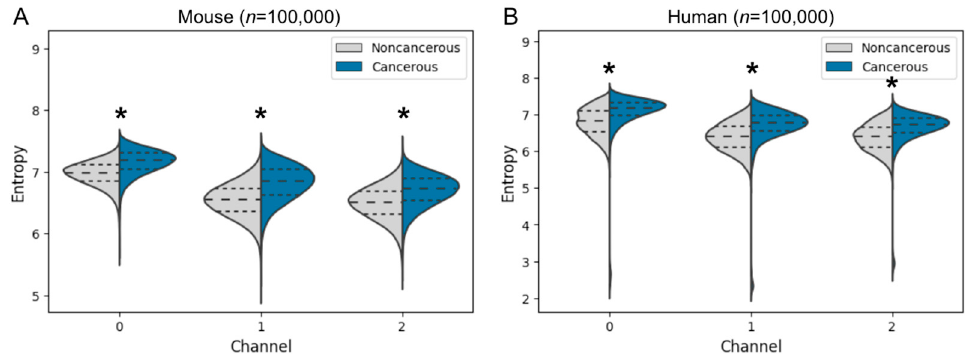
Figure 5. Entropy of pixels in each channel for noncancerous and cancerous regions of mouse ( A ) and human ( B ) histopathology images. Channels 0, 1, and 2 correspond to red, green, and blue, respectively. Dashed lines indicate the median, and dotted lines the first and third quartiles. * p < 0.001 (Welch’s t -test).